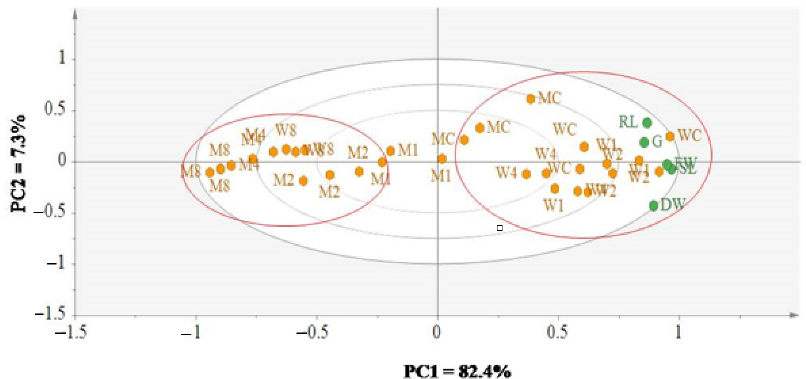
Figure 8. Effect of various concentrations of H. persicum aqueous extract on seed germination and seedling growth in black mustard. MC = Mustard control; M1 = 1% concentration; M2 = 2% concentration; M4 = 4% concentration; M8 = 8% concentration; G = Germination percentage; DW = Dry weight; FW = Fresh weight; SL = Shoot length, and RL = Root length.